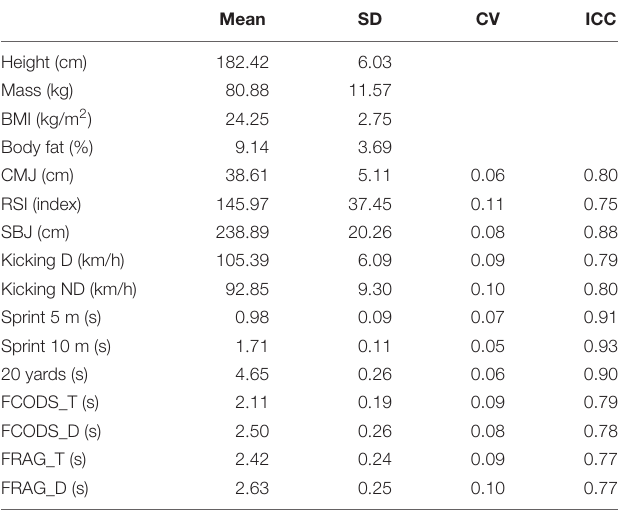
TABLE 1 | Descriptive statistics (mean, SD – standard deviation) and reliability parameters (ICC, intraclass coefficient; CV, coefficient of variation) for studied